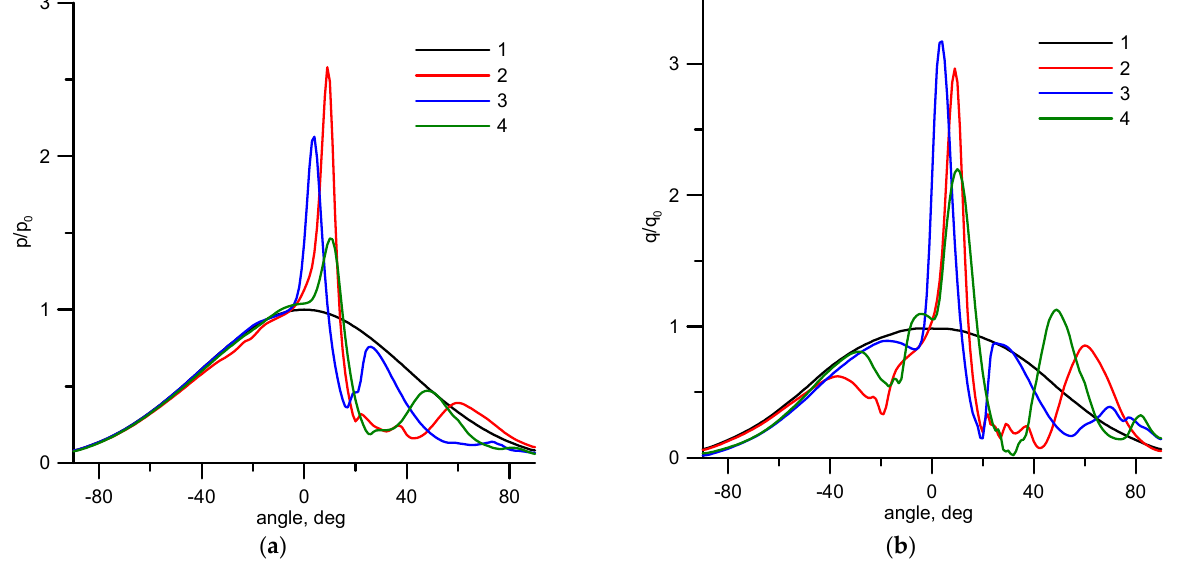
Figure 10. Distributions of pressures ( a ) and heat fluxes ( b ) along the surface at successive times for the variant with three particles. 1—initial moment, 2—0.38 ms, 3—0.63 ms, 4—0.79 ms.